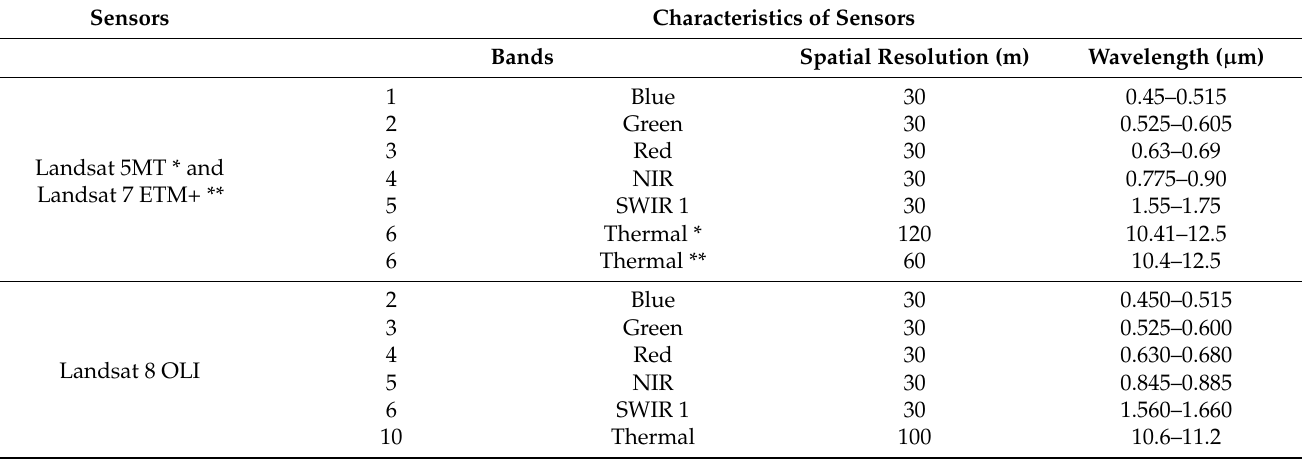
Table 2. Characteristics of remote sensors (https://landsat.gsfc.nasa.gov/appendix/references accessed on 2 June